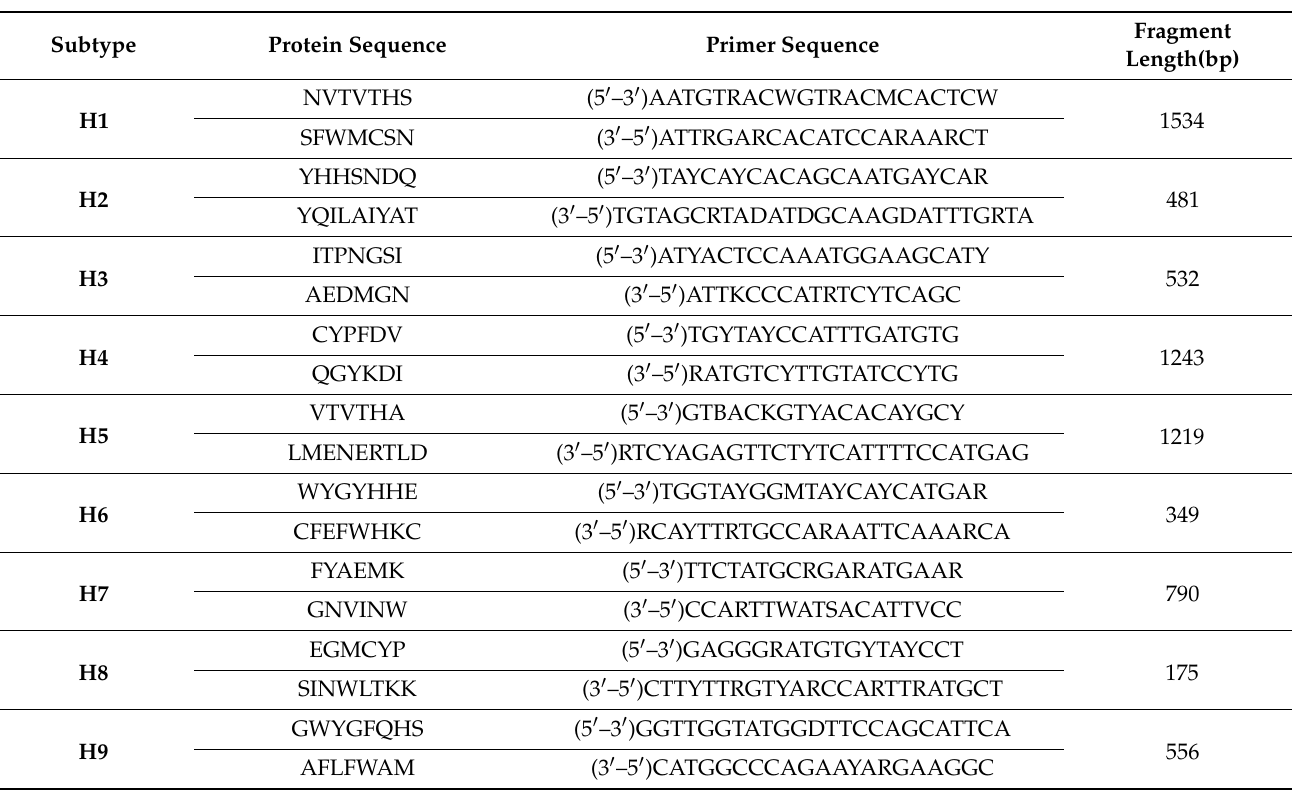
Table 3. Primer design results.